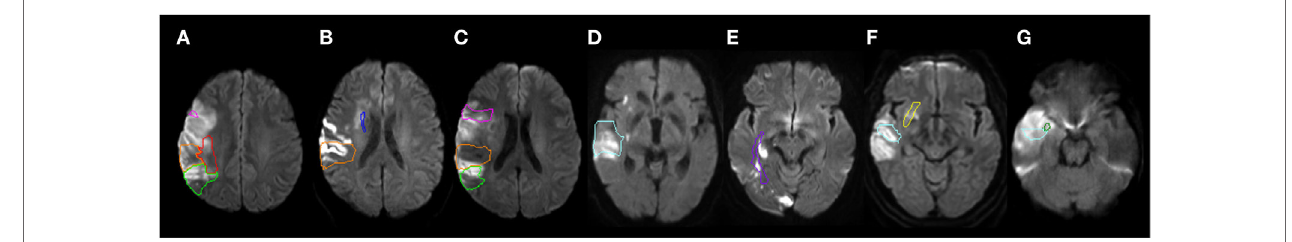
FigUre 2 | Representative individuals with acute infarction in the selected structures. The structures are color-contoured: inferior frontal gyrus, pars opercularis [pink (a,c) ], superior temporal gyrus [cyan (D,F,g) ], supramarginal gyrus [orange (a,b,c) ], angular gyrus [chartreuse green (a,c) ], inferior fronto-occipital fasciculus [yellow (F) ], sagittal stratum [purple (e) ], superior fronto-occipital fasciculus [blue (b) ], superior longitudinal fasciculus [red (a) ], and the uncinate fasciculus [green (g) ]. Diffusion weighted images were normalized to the JHU-MNI atlas space and pre-defined ROIs were overlaid on the normalized images. Images are all in radiological convention: left side of the figure is the right side of the